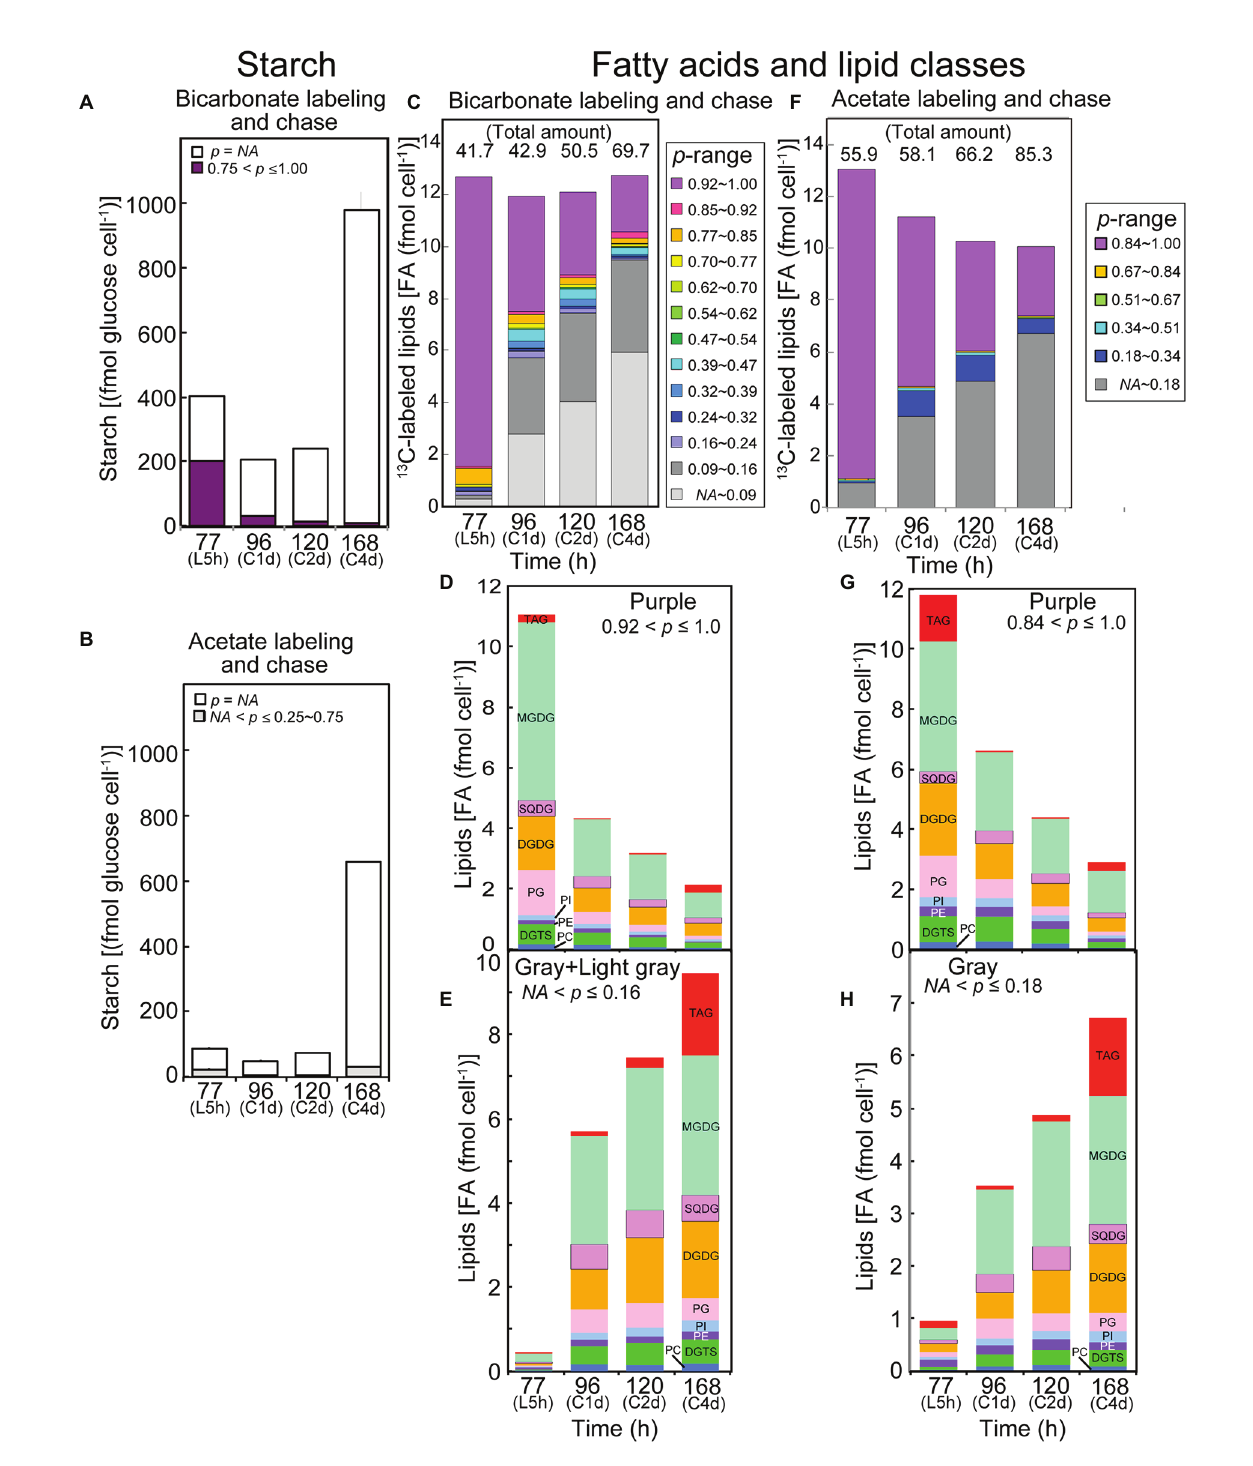
FIGURE 5 | Analysis of labeled starch and lipids in the labeling and chase experiments with [ 13 C]bicarbonate and [2- 13 C]acetate. (A,C–E) Bicarbonate labeling; (B,F–H) Acetate labeling. (A,B) Labeled and unlabeled starch. (C,F) Composition of isotopic abundance populations in total fatty acids. The amount of total lipids (as labeled plus unlabeled fatty acids) is shown on top. (D,G) Amounts of highly labeled lipid classes [purple population in (C,F) , respectively]. (E,H) Amounts of low- p lipid classes [gray + light gray, or gray populations in (C,F) , respectively]. Note that the number of steps in isotopic abundance is different in bicarbonate labeling and acetate labeling, because the maximum number of labeled carbons is different in the two